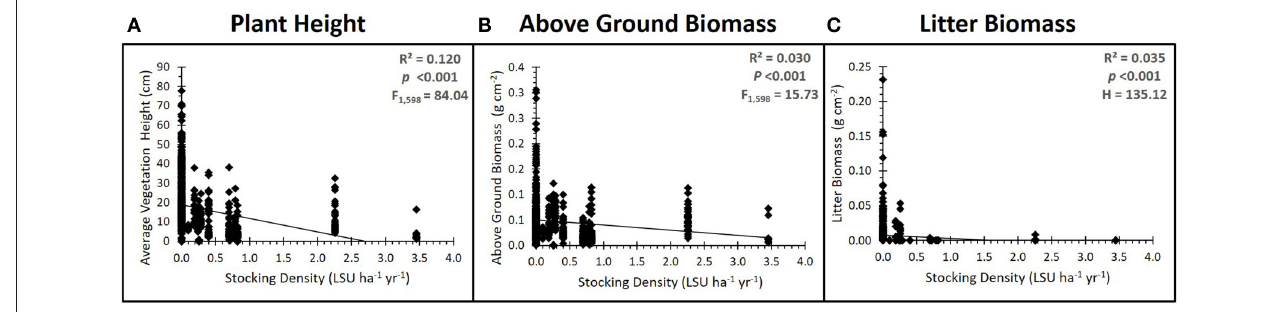
FIGURE 2 | Grazing impacts on above ground vegetation. Results of the regression analysis showing the relationship between grazing intensity (stocking density, LSU ha − 1 ) and (A) average vegetation height, (B) above ground biomass and (C) litter biomass. All significantly decreased with an increase in stocking density, with litter biomass reducing to almost zero as soon as grazers are